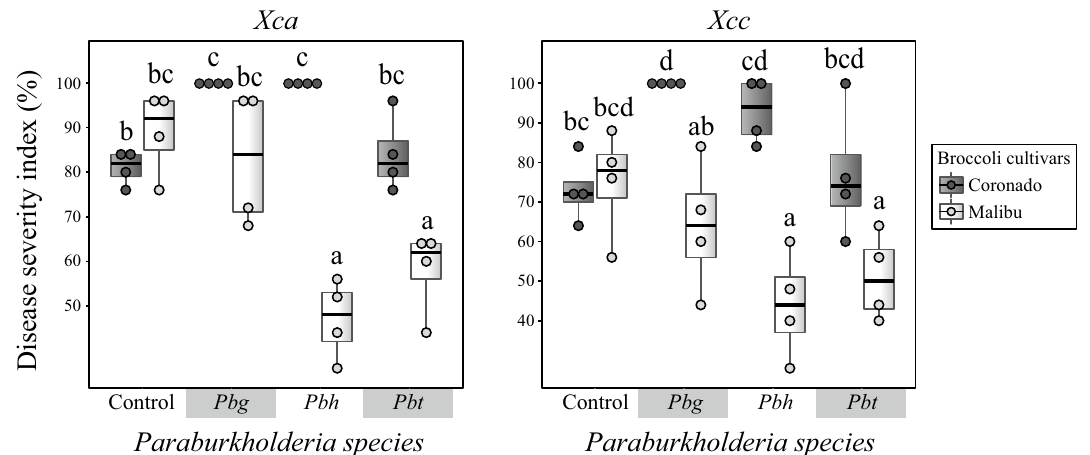
Figure 5. Impact of root-colonizing Paraburkholderia species on defense of Broccoli cultivars against two bacterial leaf pathogens. Disease severity index of two broccoli cultivars pretreated with either one of the three Paraburkholderia species and challenged with two bacterial leaf pathogens Xanthomonas campestris pv. armoraciae P4216 ( Xc a) and Xanthomonas campestris pv. campestris P4014 ( Xc c). Broccoli cultivars (Cor: Coronado, Mal: Malibu), Control: non-treated control, Pbg : Paraburkholderia graminis PHS1, Pbh : P. hospita mHSR and Pbt : P. terricola mHS1. Treatments sharing the same letter are not significantly